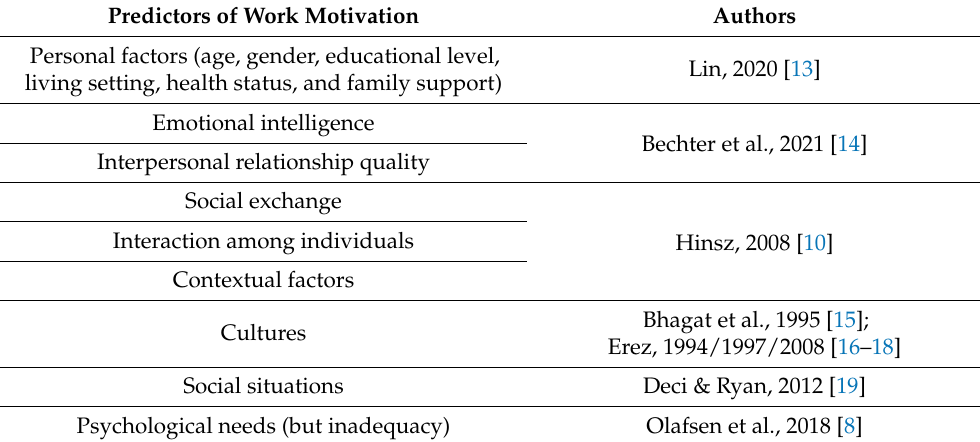
Table 1. Several investigated predictors of work motivation in general and intrinsic motivation in